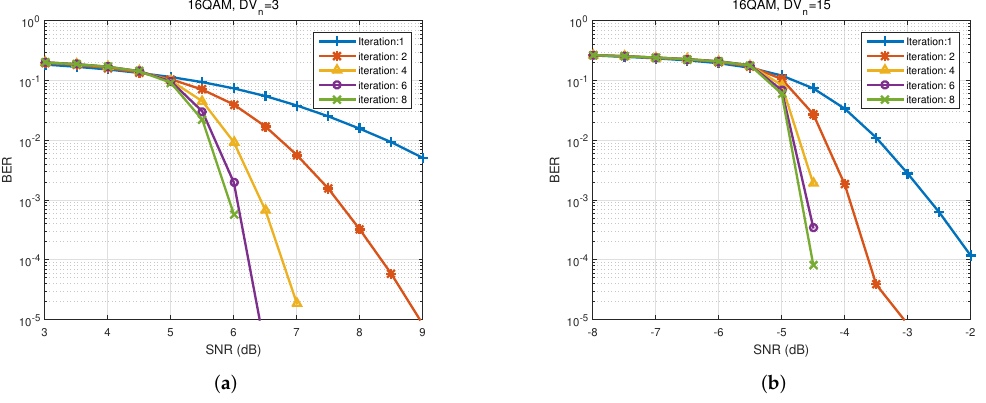
Figure 14. BER results for IoT PLC with 16QAM modulation: ( a ) DV n = 3; and ( b ) DV n =